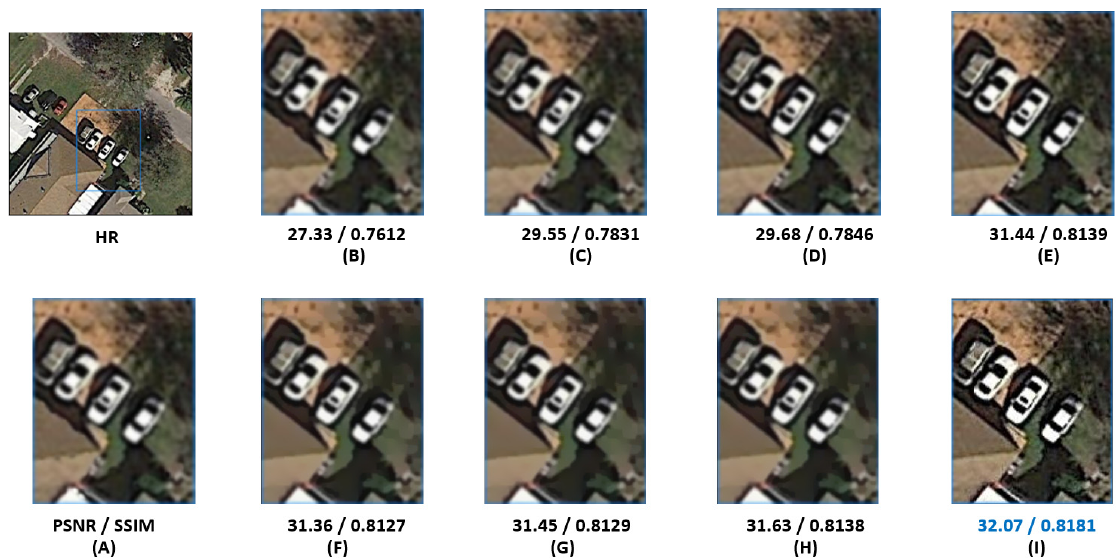
Figure 15. Comparison of values with different algorithms on the 3× “N0502” house picture: ( A ) LR; ( B ) bicubic; ( C ) SRCNN; ( D ) FSRCNN; ( E ) VDSR; ( F ) EDSR; ( G ) LapSRN; ( H ) SRGAN; ( I ) ours.